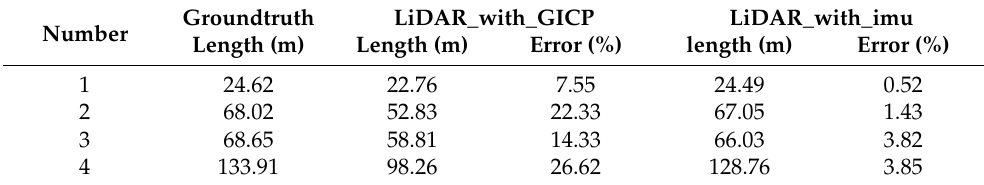
Table 2. Comparison of track length error.